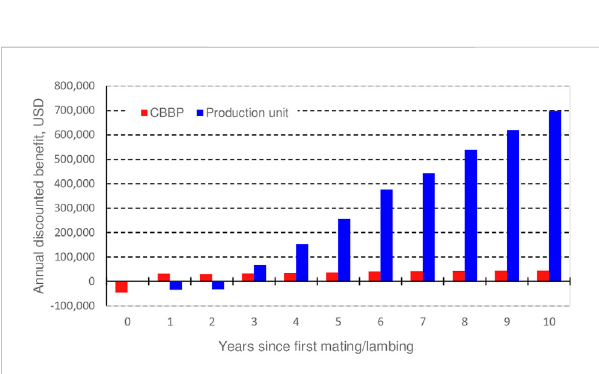
FIGURE 3 Additional annual discounted bene fi t in current CBBPs and production units. Selection starts at year 0. For CBBPs bene fi t becomes positive in year one mainly due to sale of breeding males to production units. For these, bene fi t becomes positive in year three and increases as improved genes fl ow through the